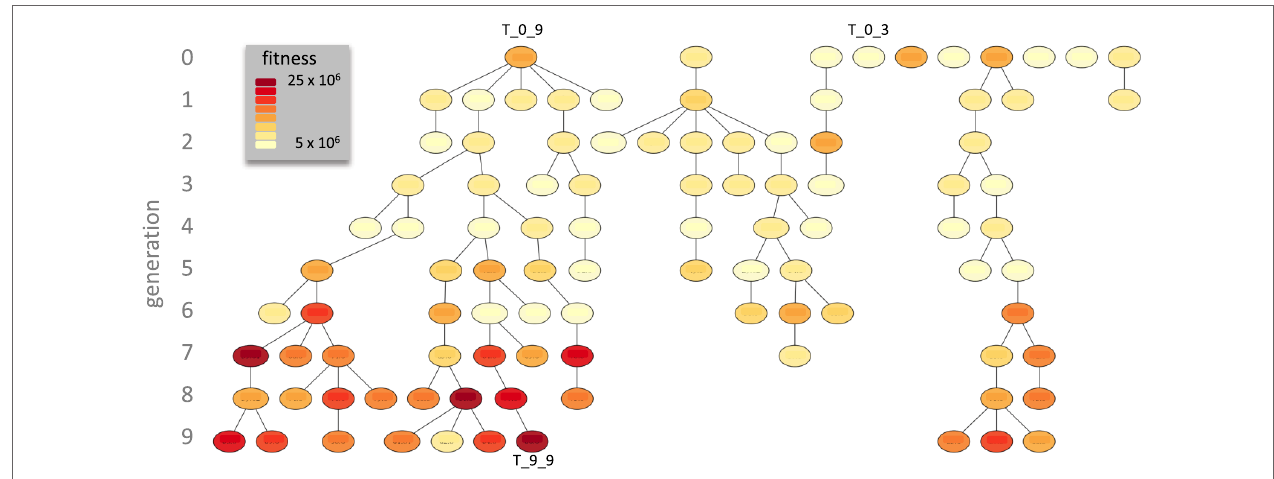
FigUre 5 | Descent of the Tadros . In this genealogy fitness, ω , is color coded and the three exemplar individuals (see Figure 4 ) are indicated. Over 10 generations of evolution, T_0_9 left the most descendants, with seven in generation